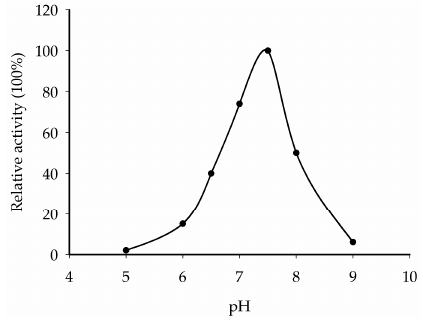
Figure 10. Representation of the pH dependence of alkaline/neutral invertase activity of CaNINV5.